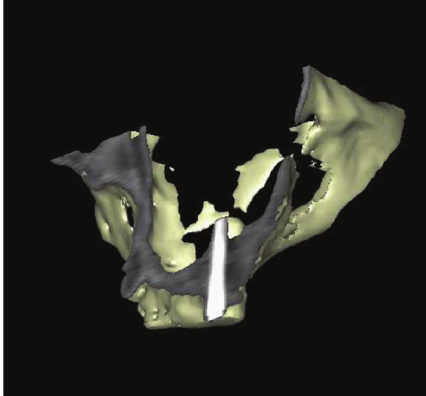
Figure 2: 3 D reconstruction of CT scan from the same patient as in Figure 1 six months postoperatively, left side. Bone is formed around implants in the maxillary sinus floor.